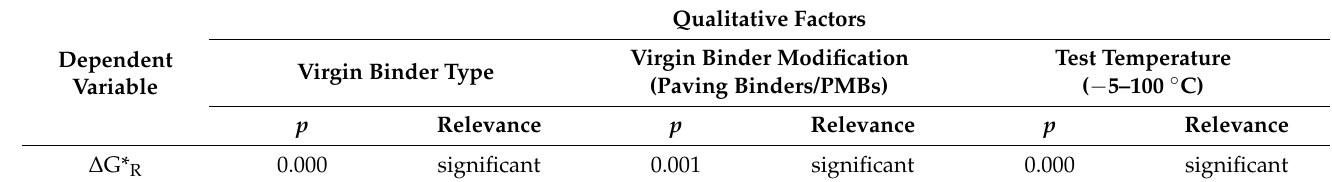
Table 6. Results of the ANOVA for ∆ G* R index and type of the binders.